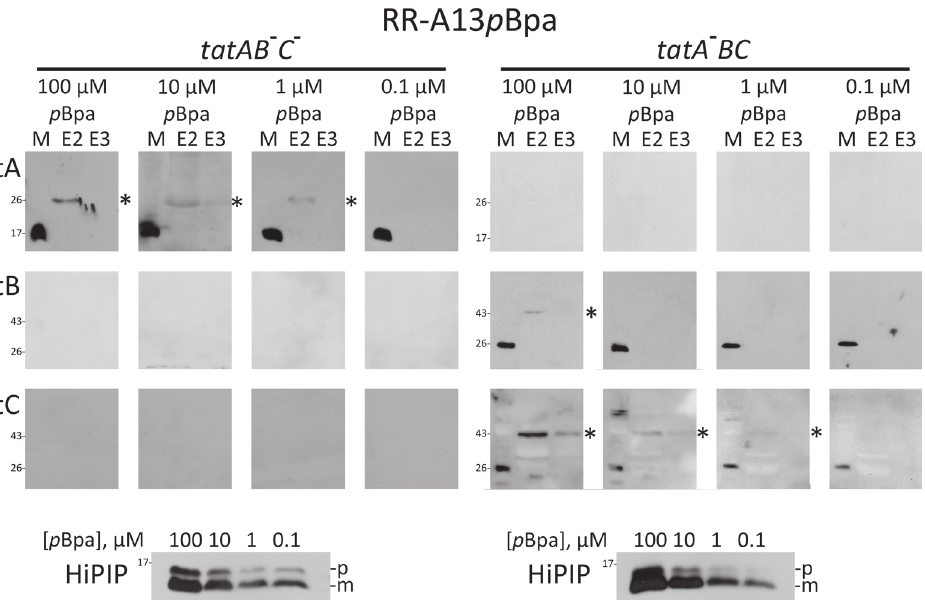
Fig 3. Substrate cross-links to TatA and TatC have comparable detection limits when substrate levels are gradually decreased. Detection of cross- links of RR-HiPIP with p Bpa at position A13 (RR-A13 p Bpa) either to wild-type level non-recombinant TatA in the absence of TatBC (left section: tatAB - C - , strain JBdBC) or to wild-type level non-recombinant TatBC in the absence of TatA (right section: tatA - BC ; strain JARV16). Note that TatA and TatC cross- links are detectable at lowered substrate concentrations as achieved with 1 μ M p Bpa in the medium. TatB cross-links are depleted below detectability already with 10 μ M p Bpa, whereas TatA and TatC cross-links both become non-detectable with 0.1 μ M p Bpa. Bottom blots: SDS-PAGE-Western blot detection of HiPIP in extracts of cells grown in the presence of indicated p Bpa concentrations. The bottom blots monitor the decrease of HiPIP levels by reduction of p Bpa concentration in the medium, as described in Fig. 2. p, precursor of HiPIP; m, mature form of HiPIP. See Fig. 1 for further